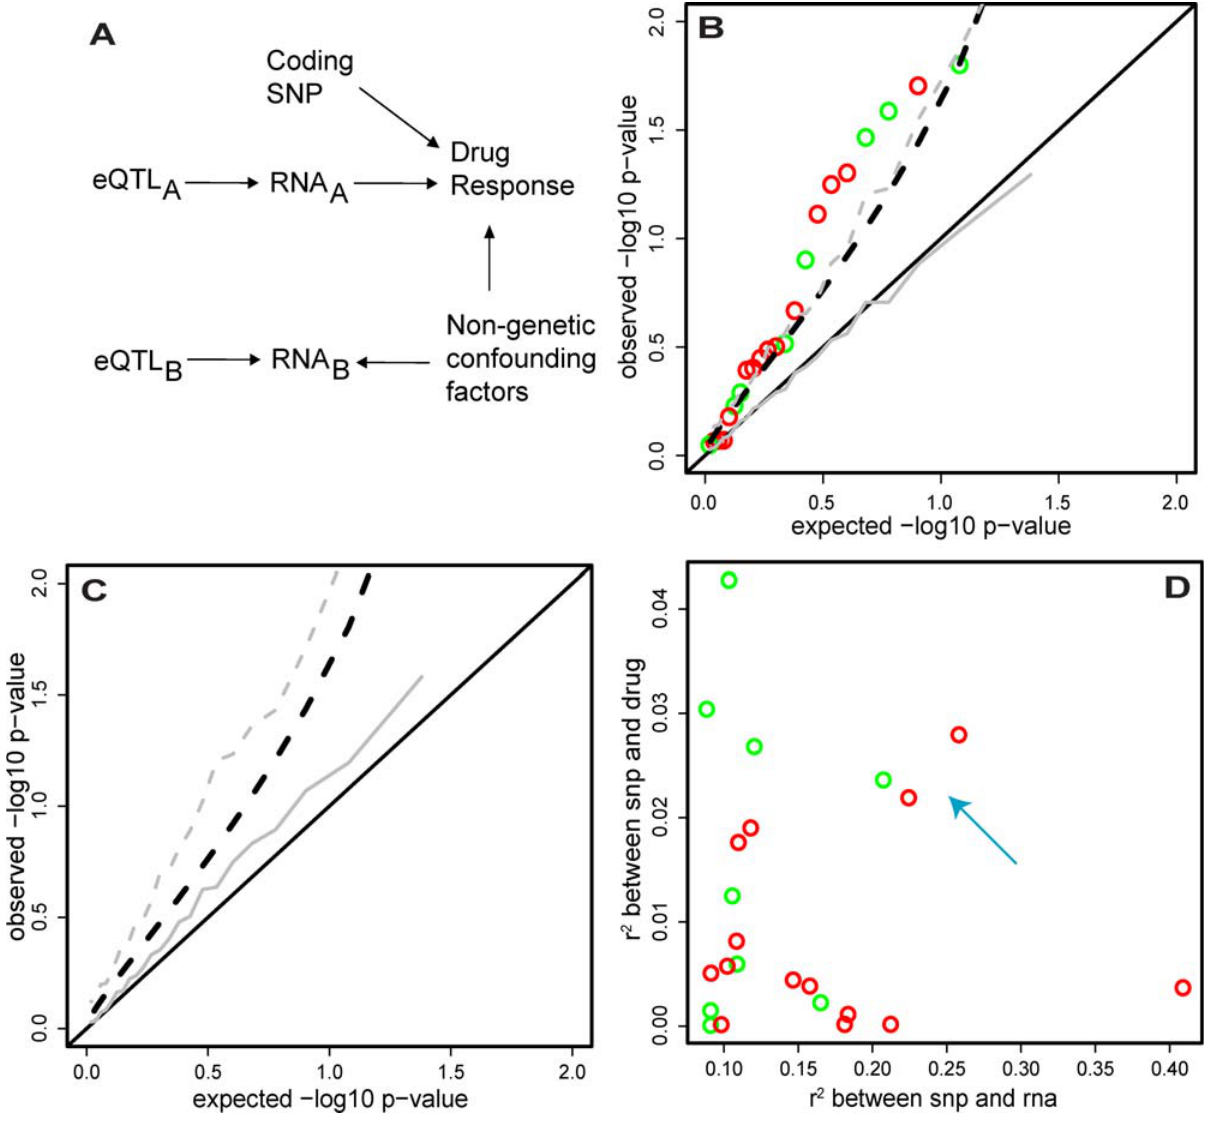
Figure 6. Effect of cis-eQTLs in drug-response correlated genes on drug-response. The 198 unrelated individuals were ranked by RNA expression value for each of the 1000 ‘‘best-measured’’ genes. These individuals were then ranked by response (growth/ATP- corrected EC50) to each of the 5 assayed drugs. Rank-correlations (spearman’s rho) were computed for each gene-X-drug pair (1000 6 5) and the drug with the strongest correlation to a given gene was ‘‘assigned’’ to that gene. The 202 genes whose strongest drug correlations exceeded rho 2 =.05 (FDR , 10%) were taken as ‘‘drug-response correlated’’ genes. If such a gene also had a cis-eQTL that explained at least 8% (FDR , 10%) of its variance, the SNP-RNA- Drug relationship was considered in the foregoing panels. We considered 23 SNP-RNA-Drug response relationships (14 derived using WTSI RNA dataset + 9 derived using the Broad Institute RNA dataset). (A) Diagram of different relationships between SNPs, RNA levels, and drug response. Coding SNPs have direct (non-RNA mediated) effects on drug response by altering protein function. No SNPs of this class were found at genome- wide significance in our GWAS scan. Changes in RNA A influences drug response. An eQTL for one of these RNAs (i.e. eQTL A ) is thereby associated with drug response.Non-genetic confounding factors simultaneously influence RNA B levels and drug response; changes in RNA B do not influence drug response (this is the expected scenario for most RNAs). Even if levels of these RNAs are associated with eQTLs, these eQTLs are not associated with drug response. (B) For each SNP-RNA-Drug response relationship (WTSI – red, Broad – green) the drug response was regressed against the eQTL SNP genotype. P-values are plotted as open circles against their expectation under the null distribution. Black solid line indicates the theoretical flat uniform distribution expected under the null and black dashed line is the p=.05 one-sided significance threshold for deviation from the null. Grey lines show equivalent null parameters, but derived from a simulated dataset with the same SNP/RNA/Drug variances and independent SNP-RNA/ RNA-Drug pairwise covariances as the real 23 SNP-RNA-Drug response relationships. Plot shows that the observed p-value distribution for drug- response regressed against RNA eQTL SNPs exceeds that expected by chance. (C) For each SNP-RNA-Drug response relationship, simulated datasets were created with the same SNP/RNA/Drug variances and RNA-Drug pairwise covariance as the real 23 SNP-RNA-Drug response relationships, but with the real SNP-RNA covariances replaced by r 2 =0.05. Then, only those simulations where the observed SNP-RNA association exceeded r 2 =0.08 were used to plot the median and p=.05 SNP-Drug p-value distributions as in (B) (again, grey solid and grey dashed lines, respectively). Black lines also as in (B). Plot shows that ‘‘winner’s curse’’ in eQTL discovery leads to an inflation of SNP-Drug associations, in the absence of any RNA influence on Drug response. (D) For each SNP-RNA-Drug response relationship (WTSI – red, Broad – green), the correlation between SNP and RNA is plotted against the correlation between SNP and Drug. Most increased association between SNP and Drug response comes from the weaker eQTLs, while most of the stronger eQTLs have no association with drug response, consistent with the winner’s curse phenomenon displayed in (C). Additionally, 3 SNP-RNA-Drug response relationships emerge that are both relatively strong SNP-RNA and SNP-Drug response associations, indicated by the light blue arrow. doi:10.1371/journal.pgen.1000287.g006 PLoS Genetics |